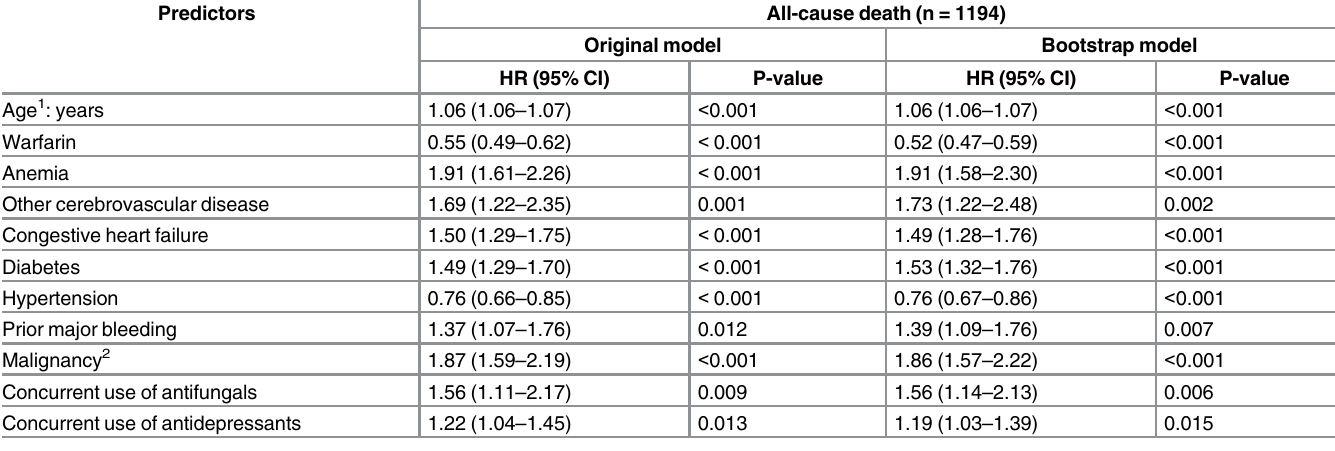
Table 5. Results of the Cox model for death in the KPCO-I cohort.